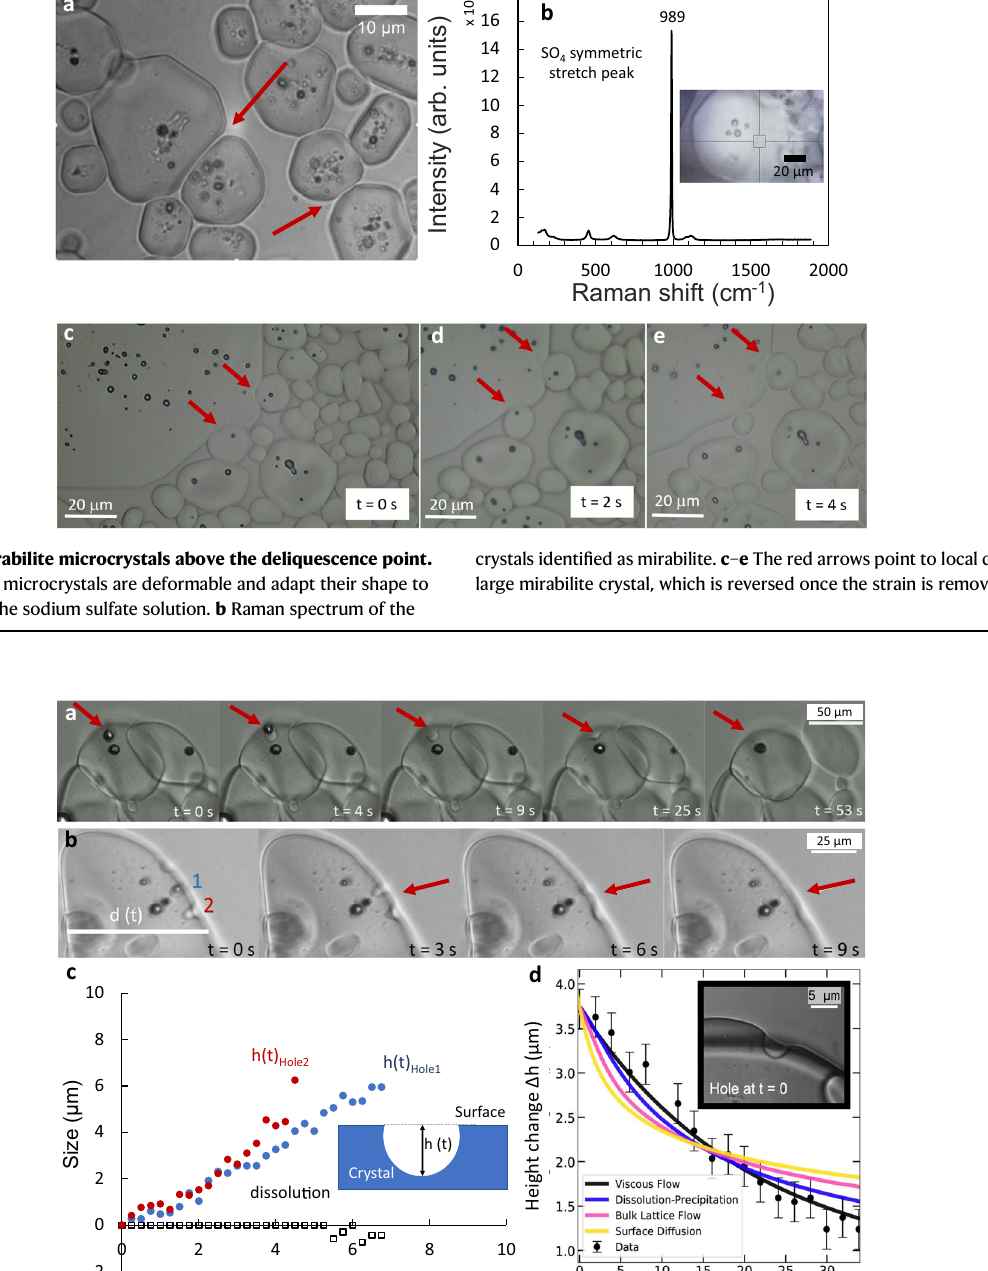
Fig. 3 | Self-healing behavior at the surface ofmirabilite crystals. a, b Evolution of surface defects on two different crystals, indicated by red arrows. During deli- quescence,whiletheentrappedthenarditedissolves,theindentationatthesurface ofthehydratedcrystalisseentoleveloutrapidly. c Levellingout Δ h(t)=h(t) − h 0 of twoholes( fi lledcircles,hole1inblue,hole2inred)anddissolution Δ d(t)=d(t) − d 0 of the same crystal (open squares). d Comparison between the measured depth